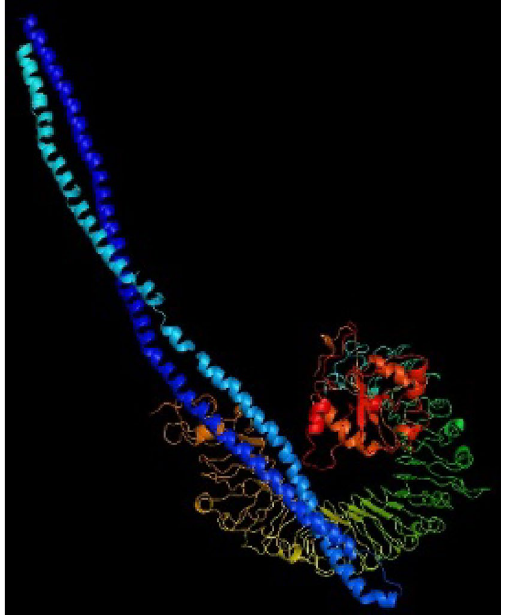
Figure 6. The docked model between the TLR5 receptor and the final designed vaccine using the ClusPro server. The vaccine protein is blue, and the rest of the residues are the TLR5 receptor. The lowest energy score of this docked model is − 1353.6, showing good binding affinity.